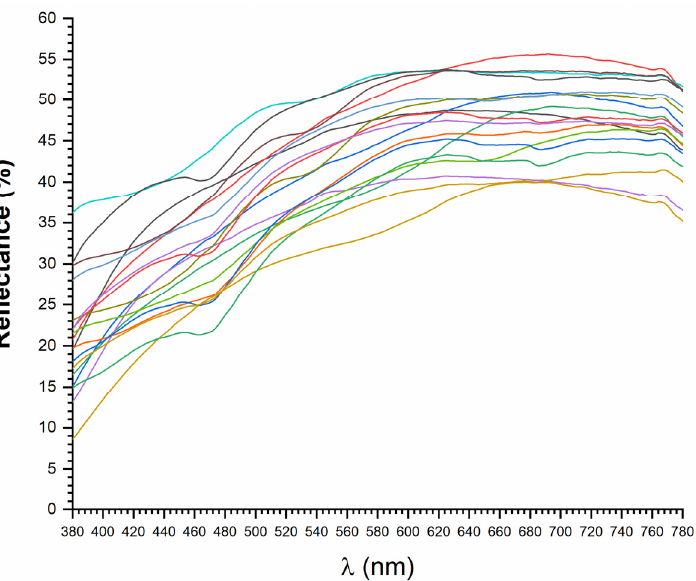
Table 1. Characteristics and information on the ceramic materials included in this study. All resin- Figure 1. Experimental device configuration used for color measurements. based composite data were provided by manufacturers.